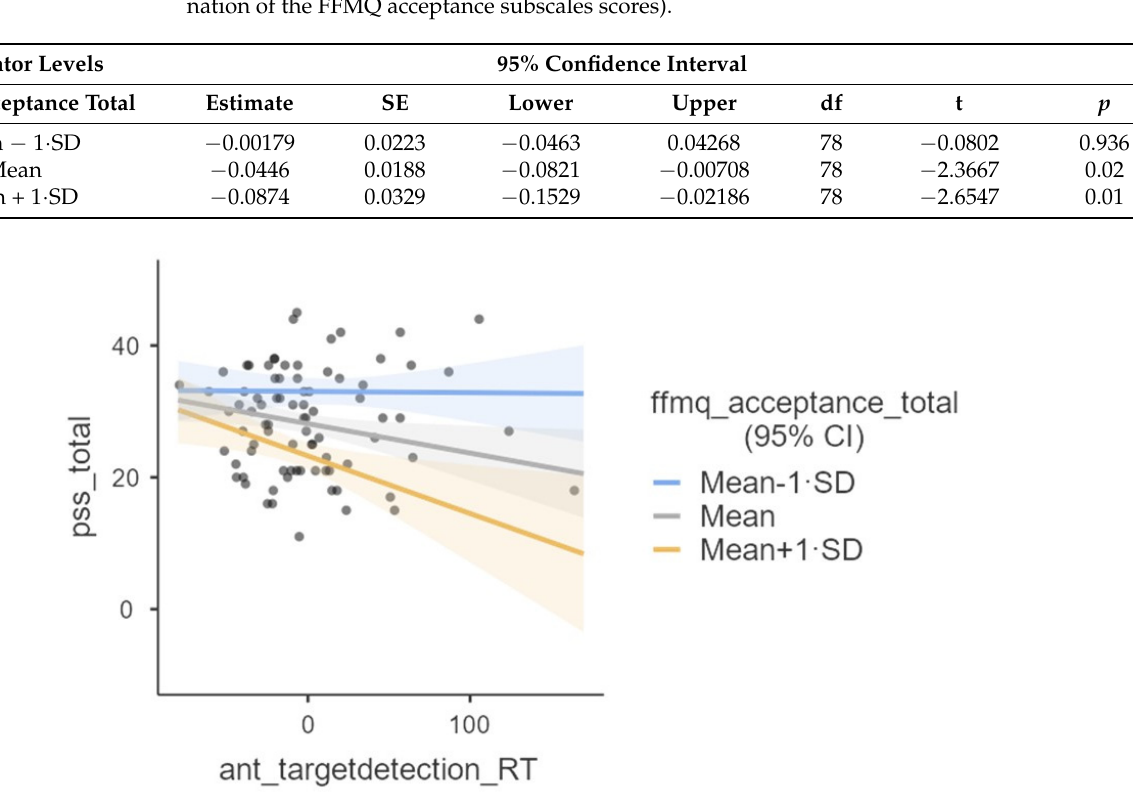
Figure 2. Visual representation of changes in the association between Chronic Stress (i.e., PSS total) and Target Detection (i.e., attention network test target detection reaction times [27]), as a function of Acceptance (i.e., five facets mindfulness questionnaire acceptance total [15]).